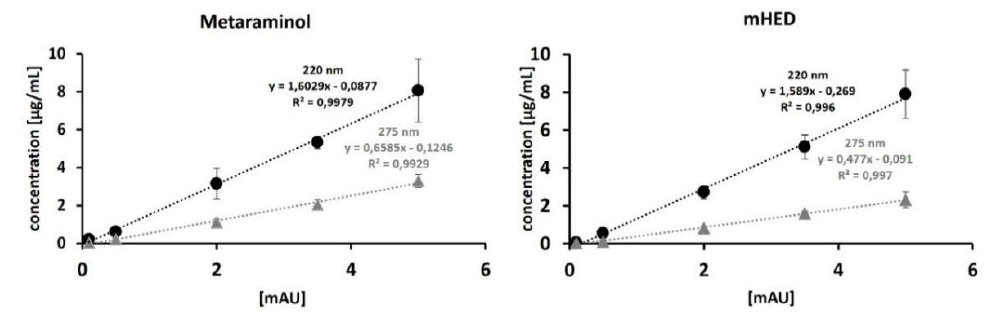
Figure 9. Calibration curve for metaraminol and m HED. Concentrations were chosen in the range of 0.1–5 µg/mL.